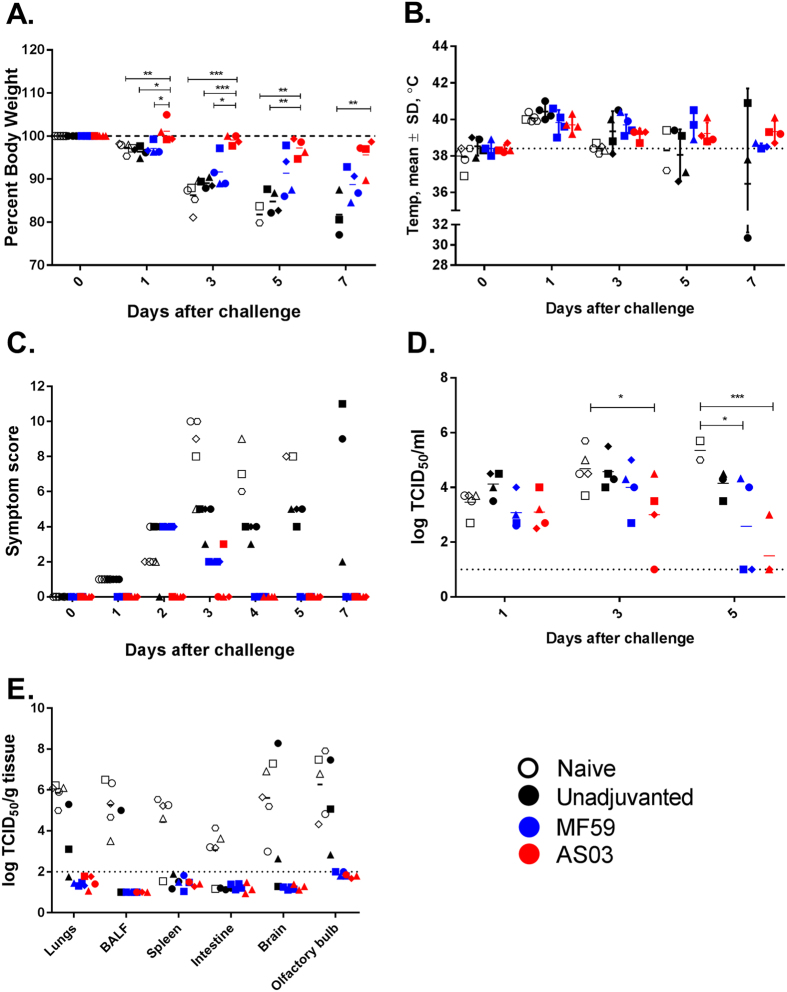
Disease severity in ferrets when challenged with wild-type A/Viet Nam/1203/2004 (H5N1). (A) Percent body weight. (B) Temperature change. (C) Cumulative symptom scores. (D) Viral load in the nasal cavity. (E) Replication of virus in extrapulmonary tissues after infection. Ferret 498 is indicated by ▲. *p < 0.05, **p < 0.01, and ***p < 0.001 by one-way ANOVA.